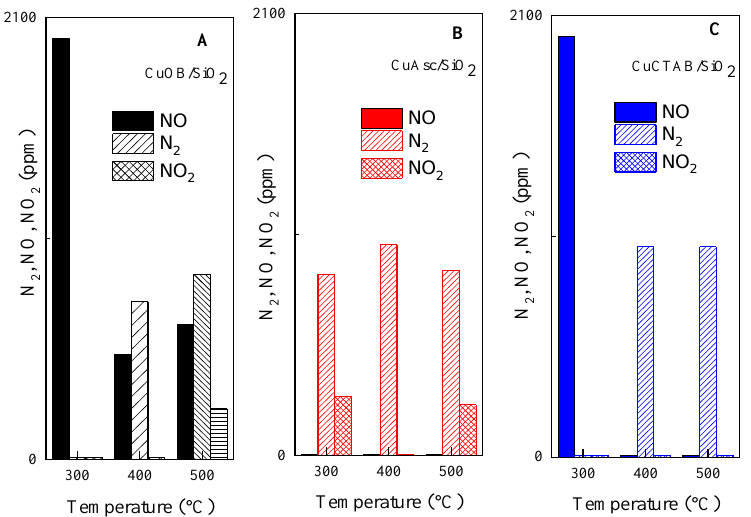
Figure 9. Catalytic activity of A: CuOB / SiO 2 , B: CuAsc / SiO 2 , and C: CuCTAB / SiO 2 for the NO reduction